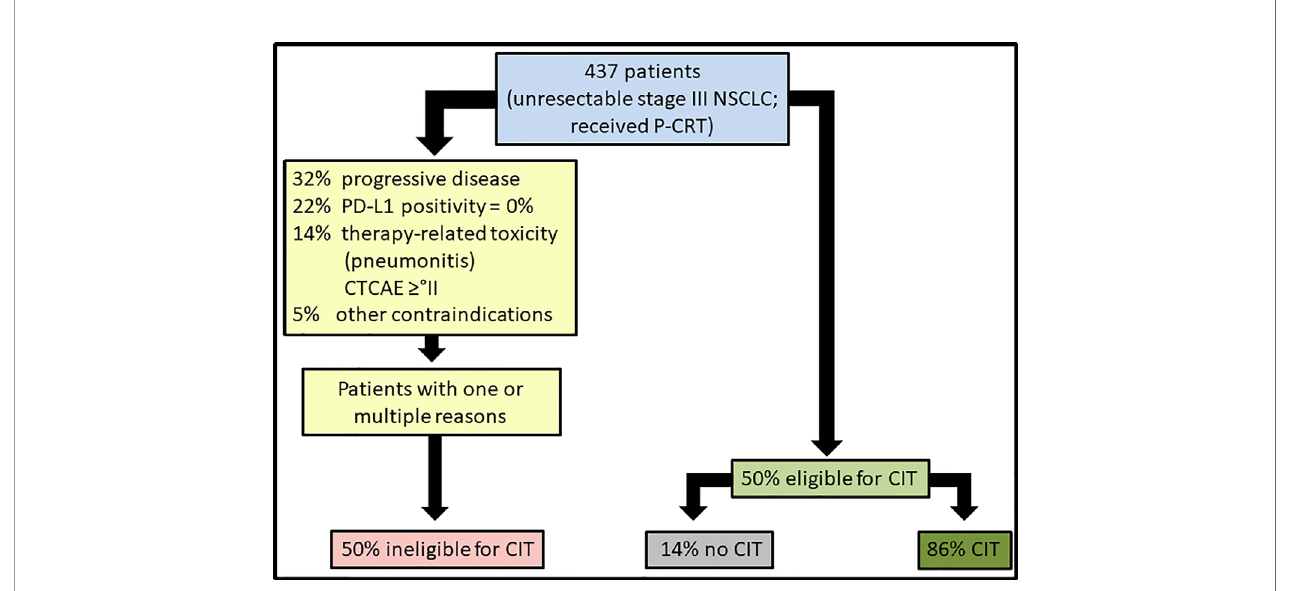
FIGURE 1 | Eligibility and administration rates of consolidation immunotherapy (CIT) with durvalumab according to PACIFIC criteria. CIT, consolidation immunotherapy; CTCAE, Common Terminology Criteria for Adverse Events; NSCLC, non-small cell lung cancer; P-CRT, de fi nitive platinum-based chemoradiotherapy; PD-L1, programmed death-ligand